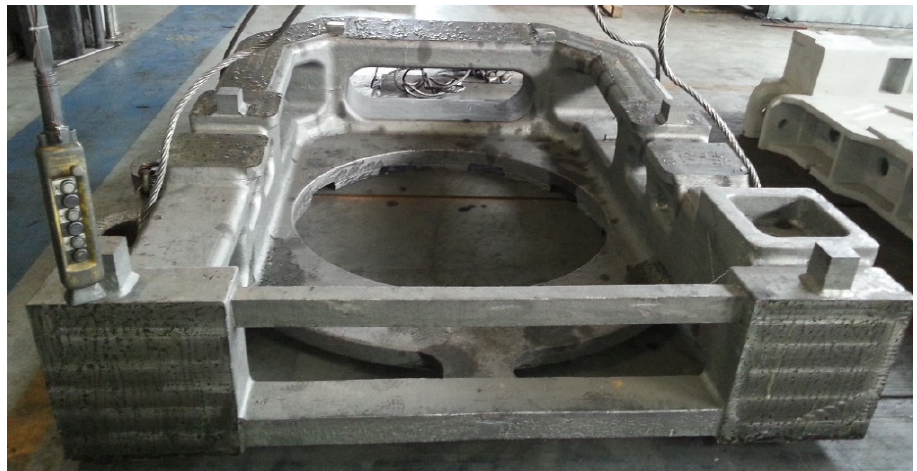
Figure 14. Finalized cast part of the hybrid bedplate.